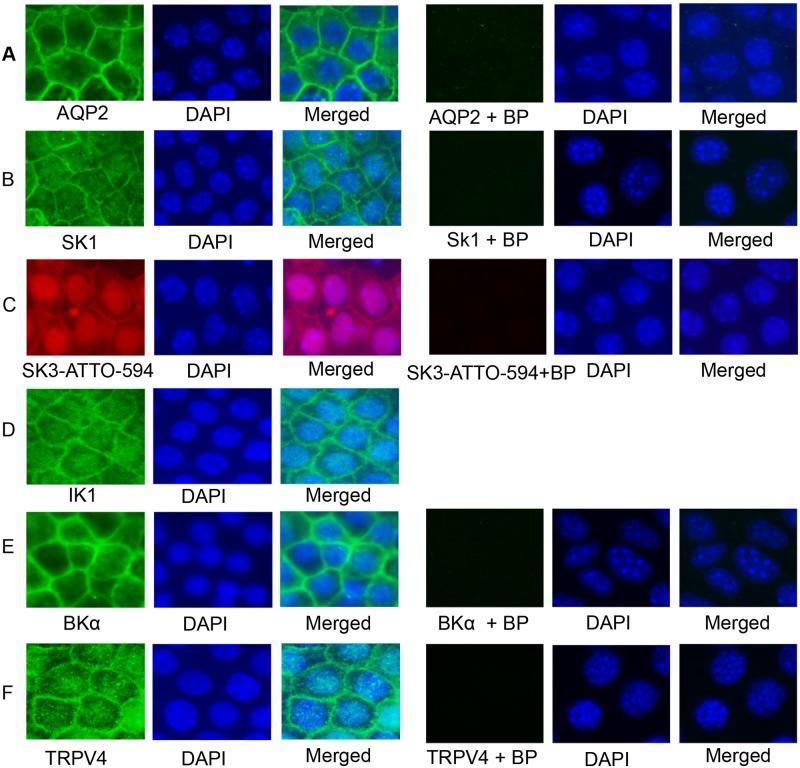
Immunocytochemistry fluorescence images (wide-field fluorescence) of staining for ion channels with or without the control blocking peptides (BP) for the respective primary antibodies.mCCDcl1 cells were grown to confluency on Transwell™ Permeable Supports. A-F. Left three columns: staining of ion channels without blocking peptides and DAPI staining of the nuclei showed similar localization immunostaining patterns as demonstrated in the confocal images of Fig 3. Right three columns: respective blocking peptides (+BP) of the ion channel primary antibodies were used as a control to verify antibody specificity. In each case, incubation with the respective blocking peptide largely abolished the immunostaining thereby demonstrating primary antibody specificity for the channel epitope. The anti-IK1 antibody in D is a monoclonal antibody (Alomone ALM05), thereby already providing some specificity, to which a control blocking peptide is not available. All fluorescence images were obtained at 100X (oil) with a Zeiss Axioskop 40 wide-field fluorescence microscope using an AxioCam MRm CCD camera.